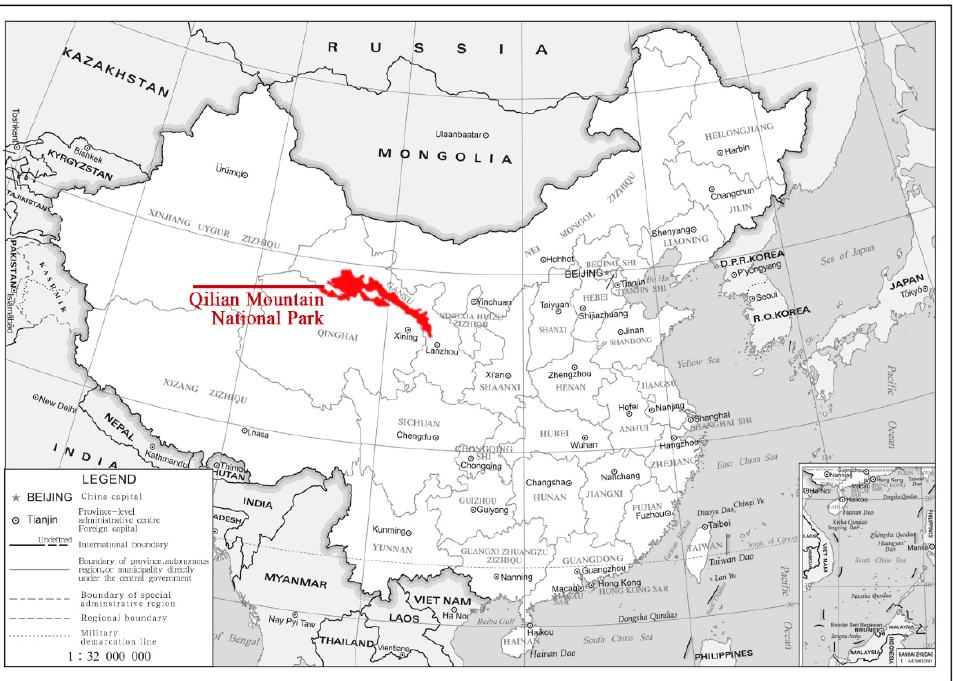
Figure 1. The location of the research area (Source: map based on a figure obtained from the Ministry of Natural Resources [53]).